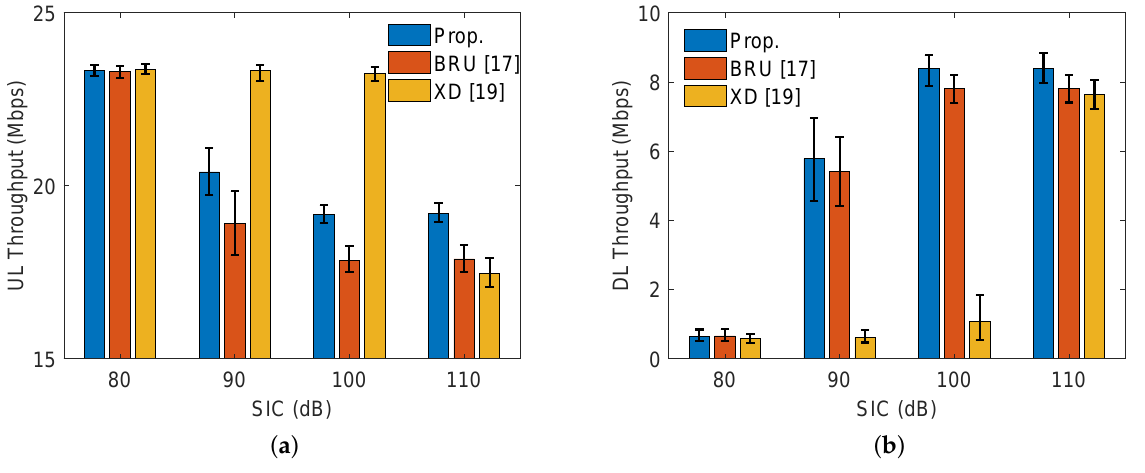
Figure 6. Throughput based on SIC ( N = 40) for ( a ) UL and ( b ) DL.